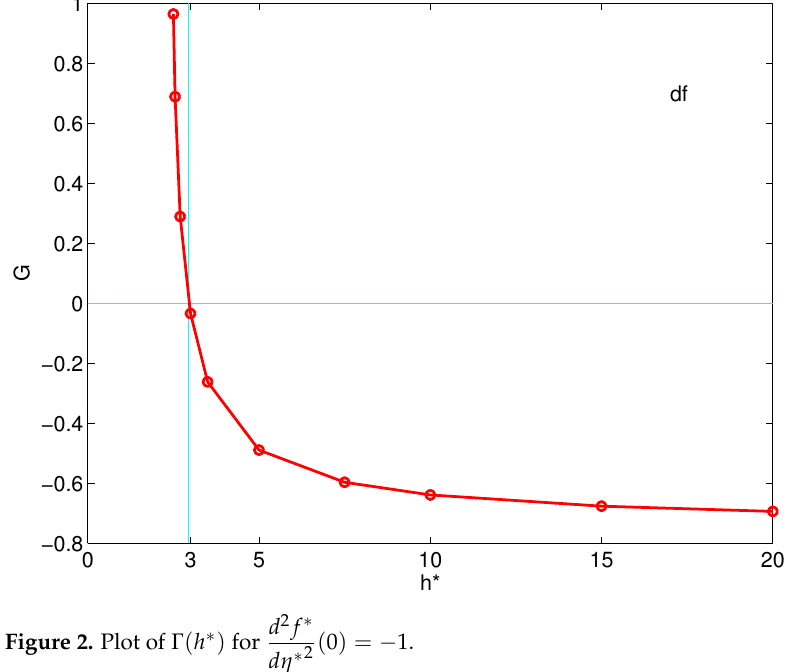
Figure 2. Plot of Γ ( h ∗ ) for